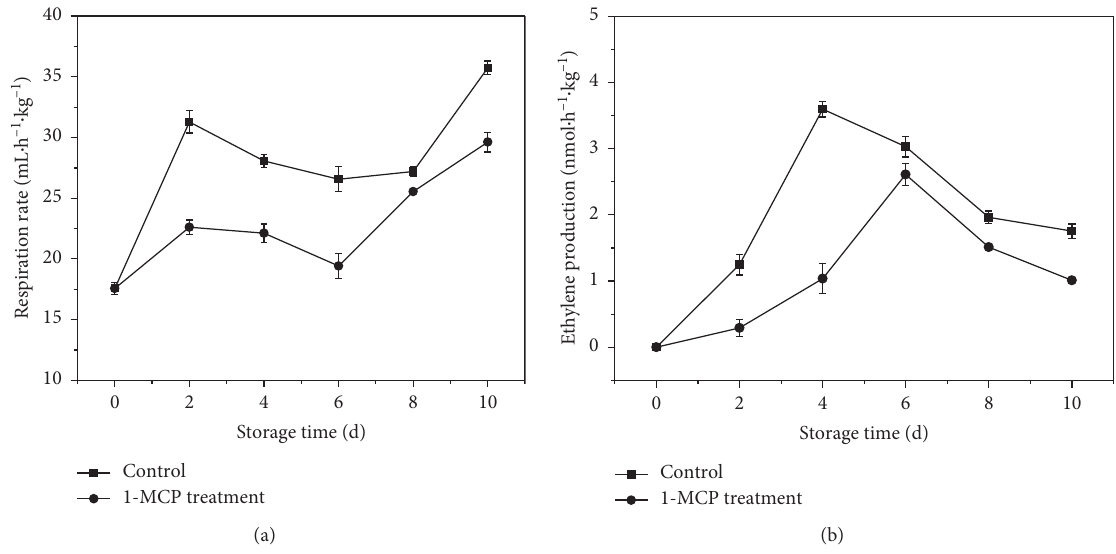
Figure 3: Effects of 1-MCP treatment on respiration rate (a) and ethylene production (b) of mango fruit during storage at 25 ° C. The data are the means of triplicates ± standard deviations.